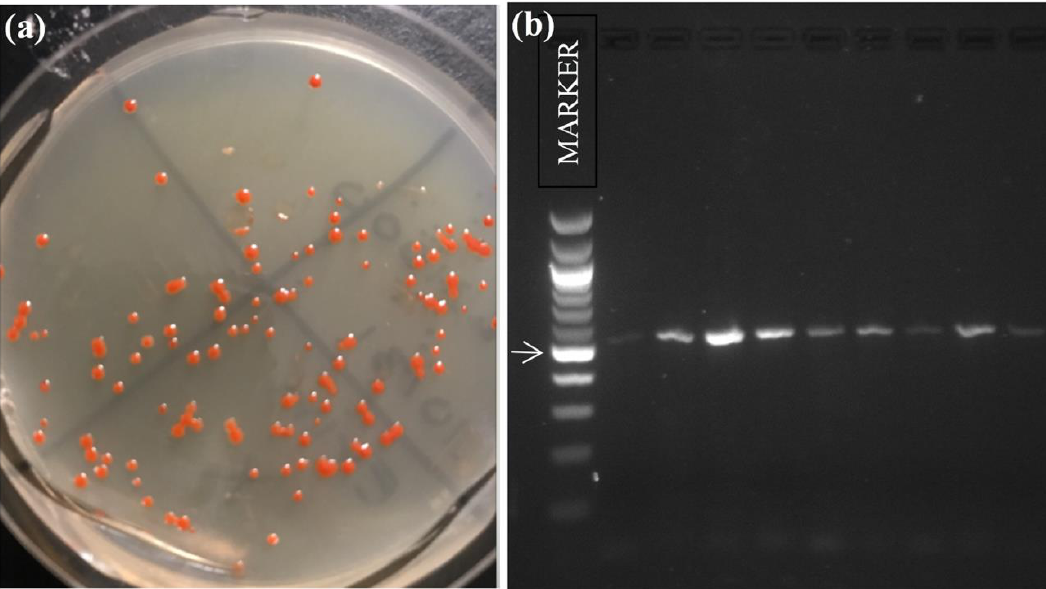
Figure 4. Evidence for microorganisms associated with the feathers of American White Pelicans. ( a ) Cultures generated by incubating feathers in salt media broth were plated on the same media in solid form; one such plate is shown. These colonies represented mixed species of halophilic archaea, and we selected ten randomly from each plate by quadrants for analysis. ( b ) Representative PCR amplification of the 16SrRNA gene from isolated species of halophilic archaea from feather cultures. The marker (100 bp DNA ladder, New England Biolabs) is in lane one, and the arrow indicates the migration of two lengths of DNA combined: 500 bp and 517 bp. Amplification with haloarchaeal primers resulted in the estimated range of 550–560 bp bands. expected for this segment of the 16S rRNA gene in halophilic archaea. Negative controls, PCR reactions with no template DNA, showed no amplification product.